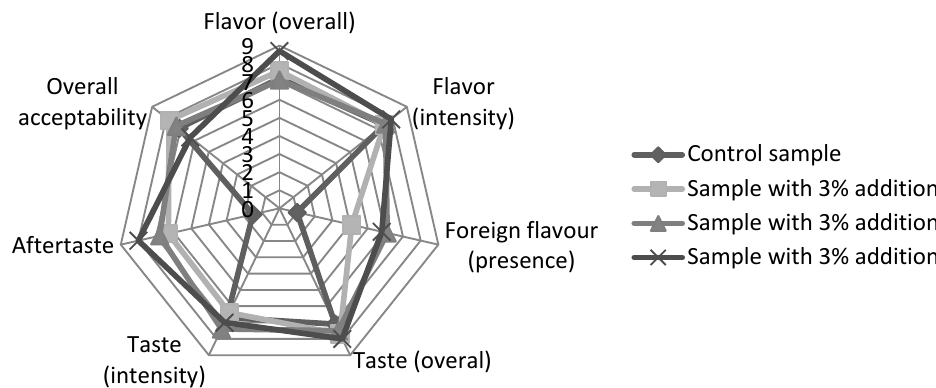
Figure 1. Sensory properties of evaluated types of pasta (sum of all panelists): CP, carrot powder; EP, elderberry powder; NP, nettle powder.